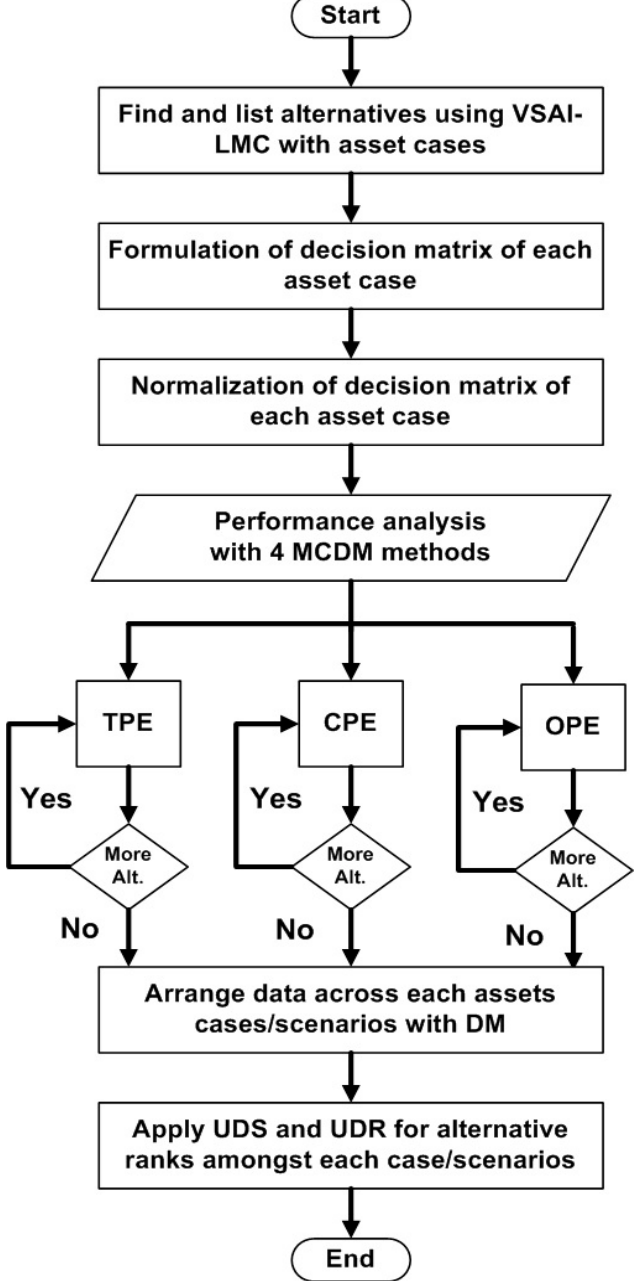
Figure 3. Flow chart of proposed integrated decision-making planning (IDMP) approach.